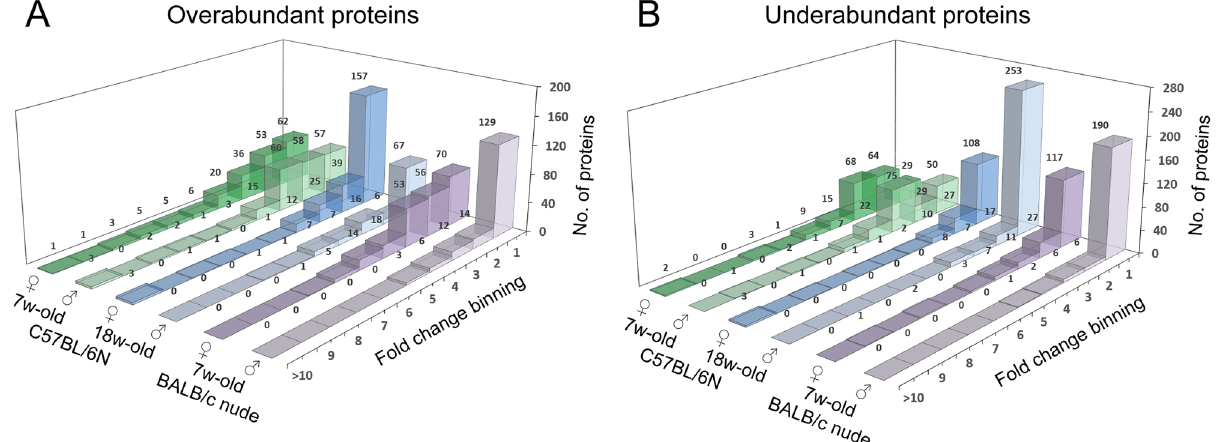
Figure 1. Fold change distribution of all filtered proteins. Histogram plots show the number (no.) of filtered proteins (i.e. accessions) with differential changes in overabundance ( A ) or underabundance ( B ) in each group in blood plasma 24 h after 0.5 Gy total body irradiation. The fold change was binned in onefold intervals from onefold up to tenfold or higher. 7w-old, 7-weeks-old (juvenile mice); 18w-old, 18-weeks-old (adult mice). ♀ , female; ♂ , male. Please note that presented data is normalized to respective unirradiated control